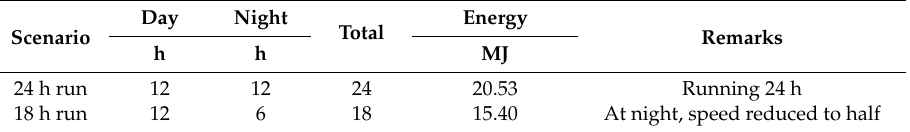
Table 2. Energy consumption by the paddlewheel.